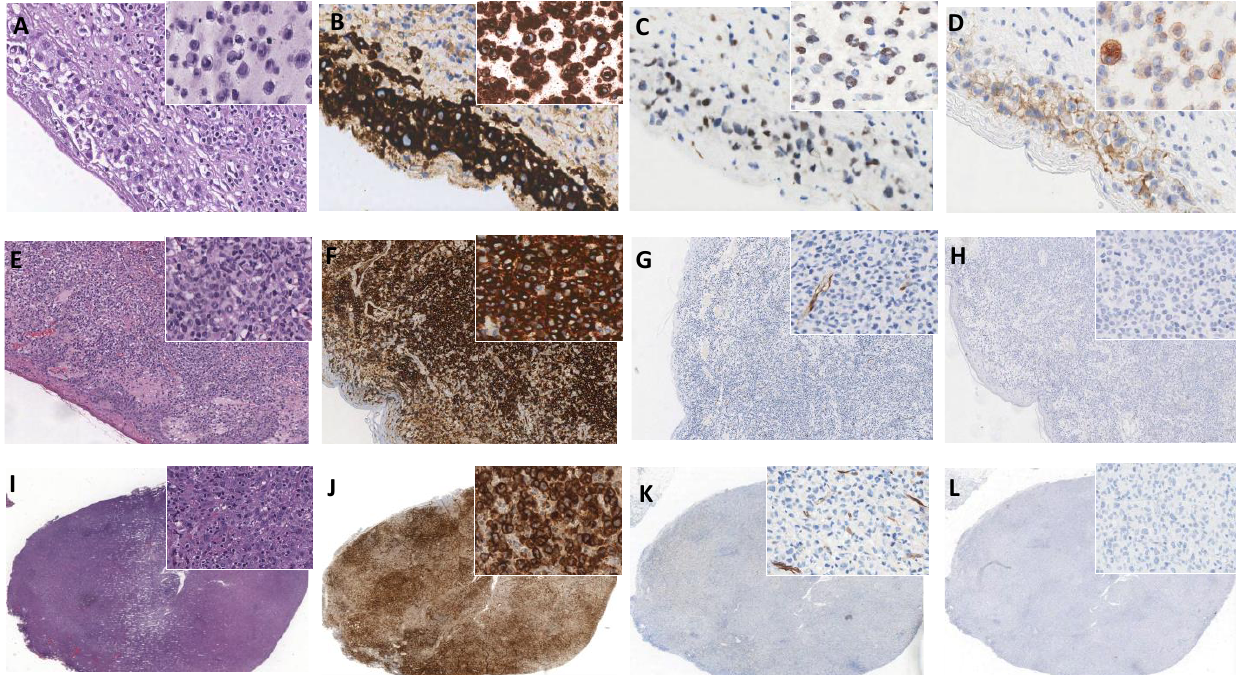
Figure 5. Immunohistochemistry of BI-ALCLs ( A – D ), cALCLs ( E – H ) and ALK+ sALCLs ( I – L ) for CD30 ( B , F , J ), WT1 ( C , G , K ) and pan-TRK ( D , H , L ). BI-ALCL tumor cells show nuclear staining for WT1 and membranous and cytoplasmic dot-like staining for pan-TRK in peri-implant breast capsular tissue (large panels, original magnification × 400) and peri-implant breast effusion (inserts, original magnification × 400). cALCLs (large panels, original magnification × 100, insets × 400) and ALK+ sALCLs (large panels, original magnification × 20, insets × 400) were negative for both WT1 and pan-TRK.